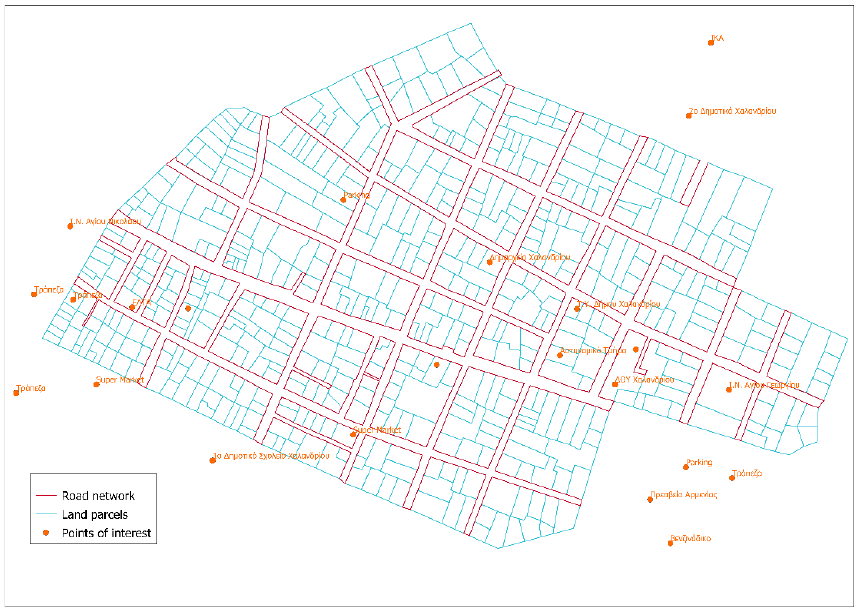
Figure 27. Final crowdsourced cadastral basemap.